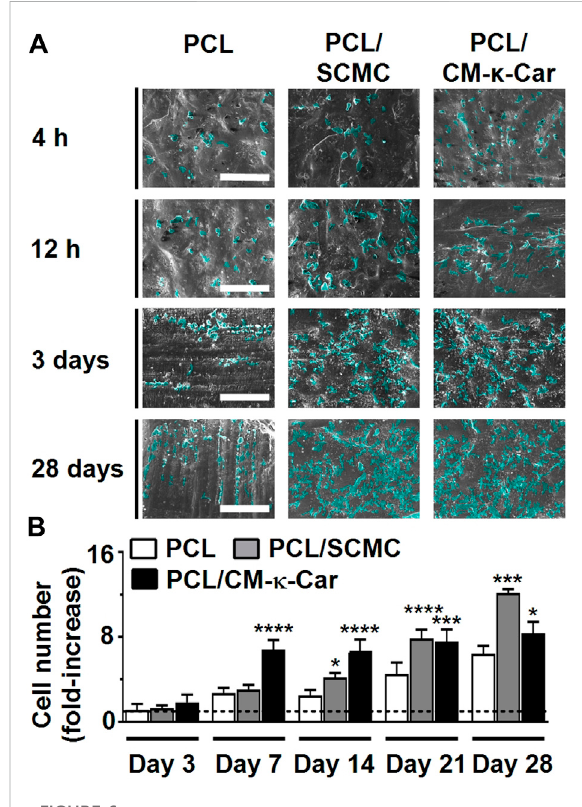
FIGURE 6 Effect of 3D-printed PCL scaffold surface-functionalization by SCMC or CM- κ -Car on MC3T3-E1 pre-osteoblast proliferation. (A) SEM images showing pre-osteoblasts after 4 h, 12 h, 3 days, and 28 days of culture. Scale bar: 200 µm. (B) Quanti fi cation ofpre-osteoblastproliferationafter3,7,14,21,and28 daysrelative to day 1. Values are mean ± SD ( n = 3). *Signi fi cantly different from unfunctionalized 3D-printed PCL scaffolds, p < 0.05, ** p < 0.005, **** p < 0.0001. PCL, poly- ε -caprolactone; SCMC, sulfated carboxymethyl cellulose; CM- l -Car, carboxymethyl κ - carrageenan; SEM, scanning electron